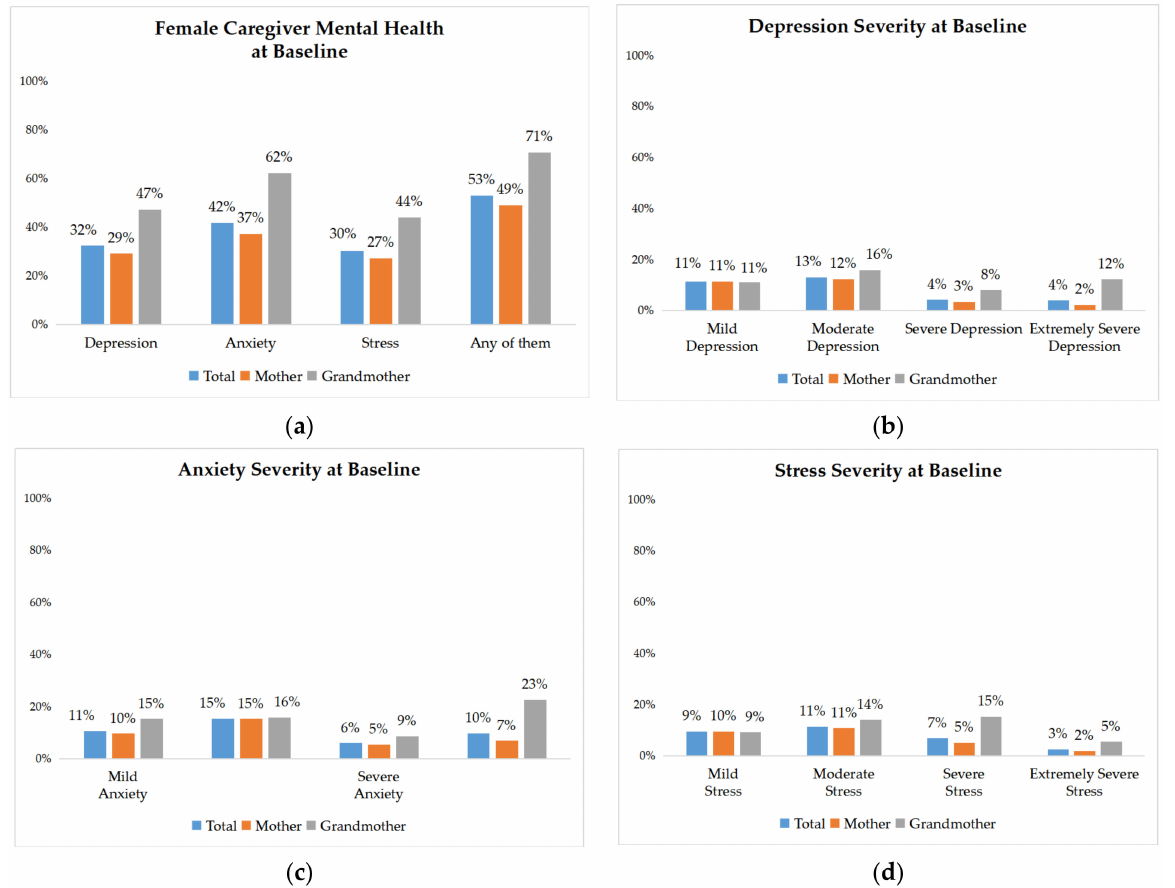
Figure 2. Female caregivers’ mental health characteristics at baseline: ( a ) Female caregivers’ overall mental health at baseline; ( b ) depression severity at baseline; ( c ) anxiety severity at baseline; ( d ) stress severity at